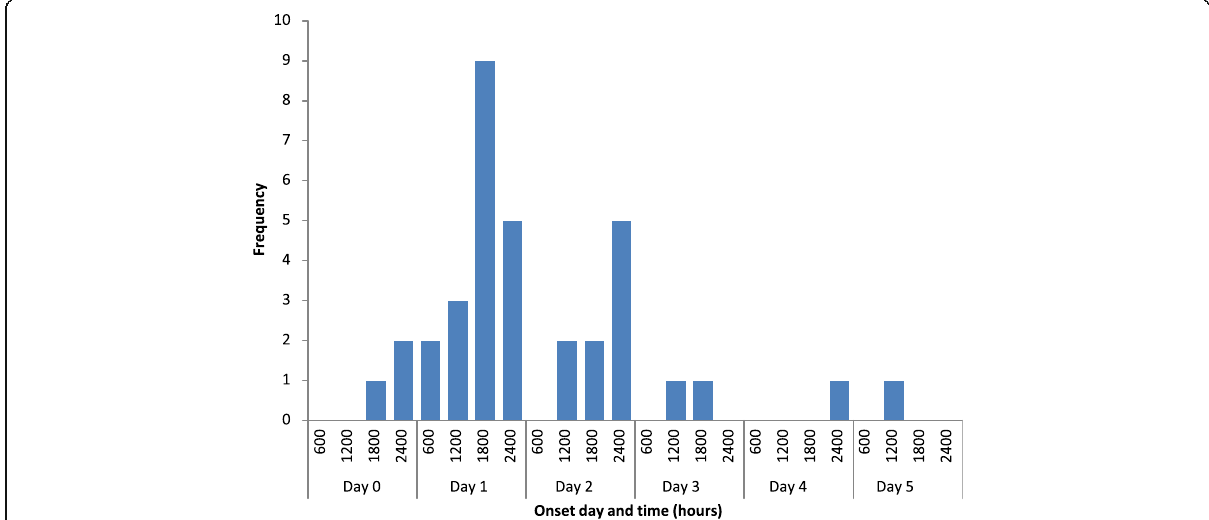
Fig. 1 Epidemiological curve showing onset of gastrointestinal illness in members of the sports club ( n =